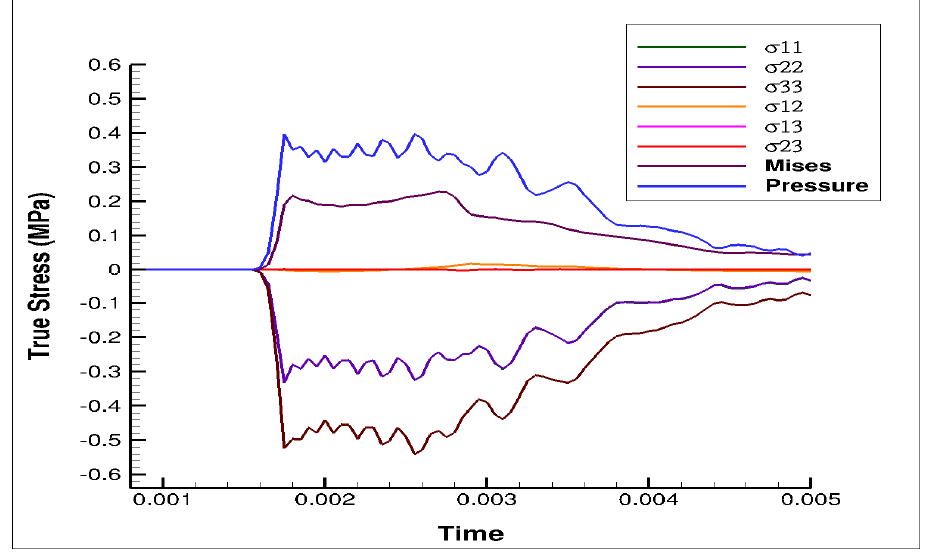
Figure 8. Plot of pressure, von Mises, and stress from different orthogonal directions ( σ 11 , σ 22 , σ 33 , σ 12 , σ 13 , and σ 23) over time, obtained from the FE simulation at 550 s − 1 . Compressive stresses are negative.